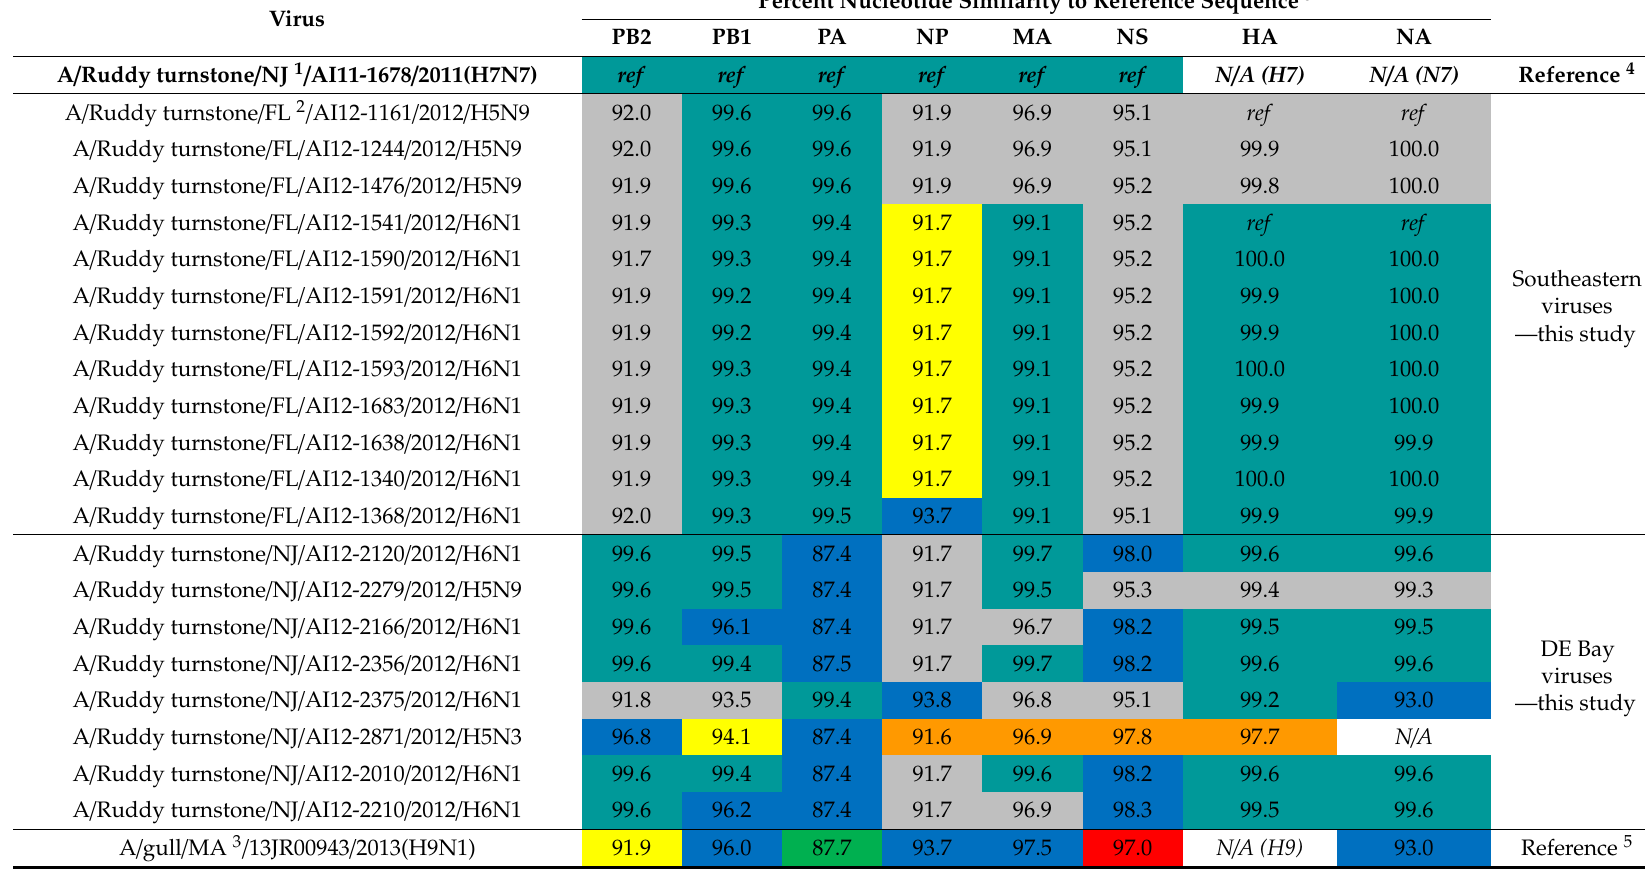
Table 3. Viruses recovered during this study that share di ff ering degrees of nucleotide (nt) identity within each gene segment. Viruses with the same color code within a given gene segment share > 99.0% nt identity. The HA and NA of the first H5N9 (AI12-1161) and H6N1 (AI12-1541) viruses isolated are the reference sequences within those respective gene